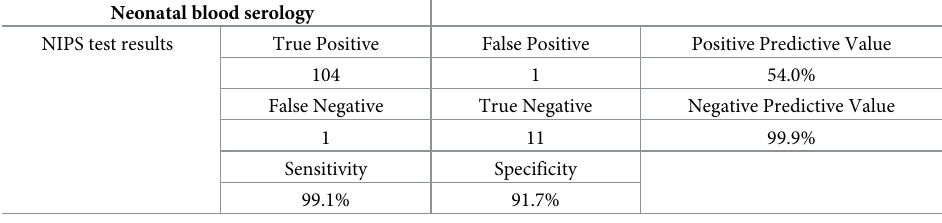
Table 2. Correlation of neonatal blood serology with non-invasive prenatal screening test for RHD